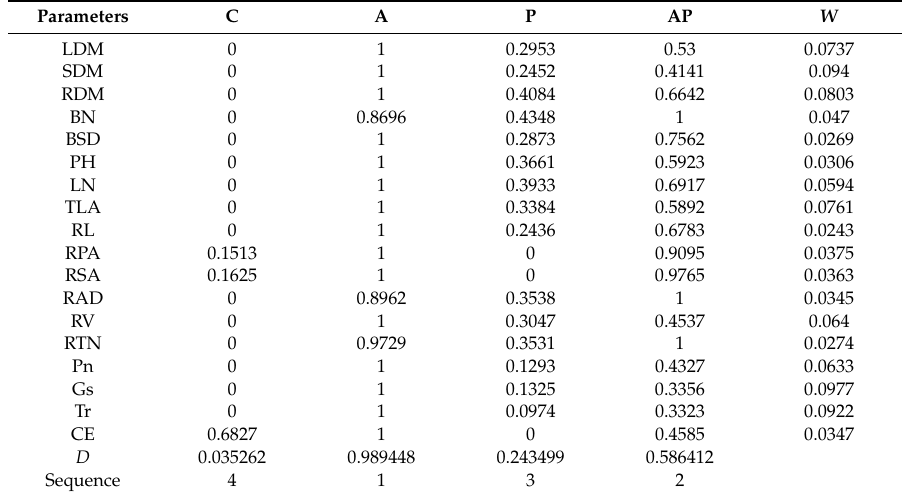
Table 1. Salt tolerance assessment of Elaeagnus angustifolia L. under different treatments using the subordinate function value method.